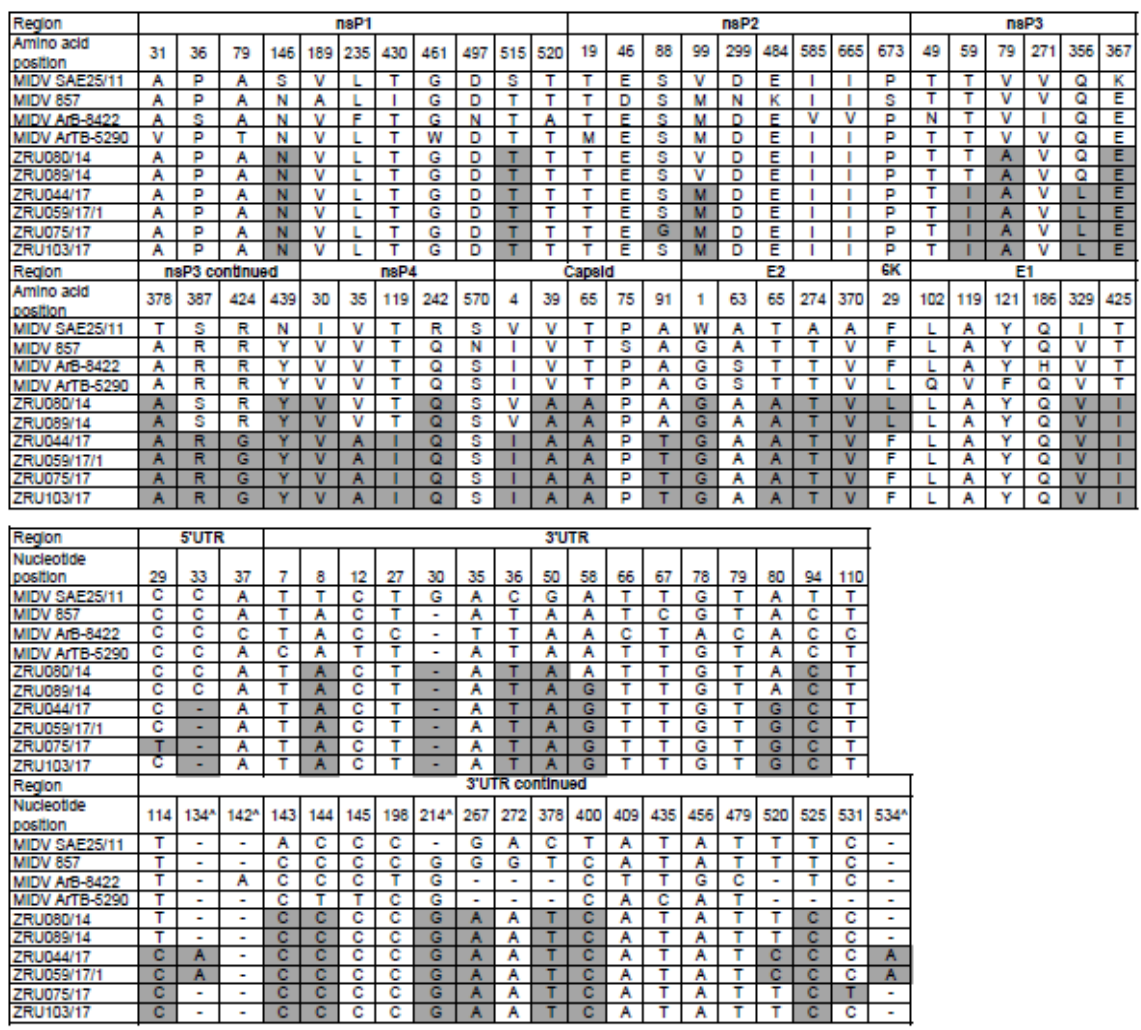
Figure 8. Amino acid and nucleotide sequence comparisons of the structural and non-structural proteins and UTR’s, respectively, between different Middelburg virus (MIDV) strains. Numbering refers to sequence positions of isolate SAE25/11. Changes in amino acid of ZRU080/14, ZRU089/14, ZRU044/17, ZRU059/17/1, ZRU075/17, and ZRU103/17 as compared to MIDV SAE25/11 are highlighted in grey. Deletions in MIDV SA25/11 compared to other sequences are indicated by “^”. Strains from 2017 share unique amino acid differences in the nsP3 (T59I, Q356L, R424G), nsP4 (V35A, T119I), capsid (A91T), 5 (cid:48) UTR (C33-) and 3 (cid:48) UTR (A80G, C114G)